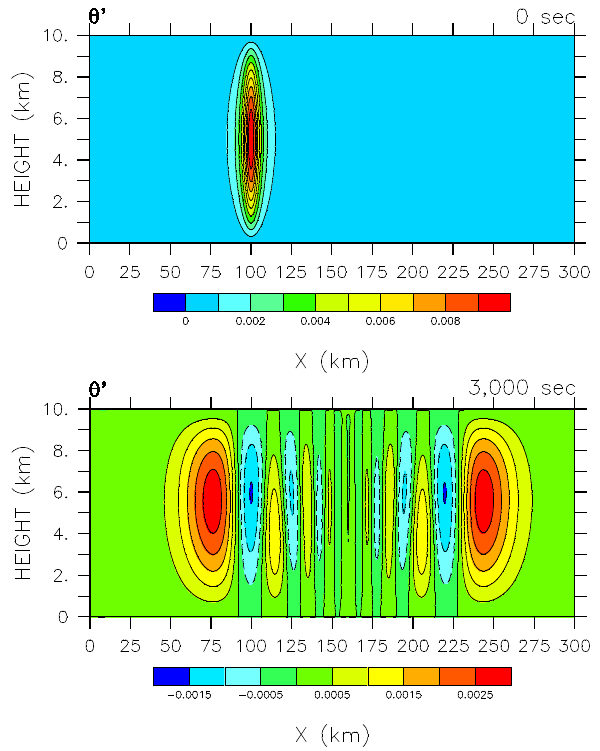
Figure 9. Potential temperature perturbation at the initial time (top) FIG. 9. Potential temperature perturbation at the initial time (top) and time 3000 s 2 and time 3000s (bottom) for (cid:49) ¯ x = 250m using eighth-order ba- (bottom) for 250x ∆ = m using 8th-order basis polynomials per element and 250z ∆ = m 3 sis polynomials per element and (cid:49) ¯ z = 250m for the inertia–gravity for the inertia-gravity wave. The contour values are from 0 (−0.0015) to 0.009 (0.0025) with 4 wave. The contour values are from 0 ( − 0.0015) to 0.009 (0.0025) with an interval of 0.001 (0.0005) for the initial time (time 3000s). an interval of 0.001 (0.0005) for the initial time (time 3000 s). 5 6